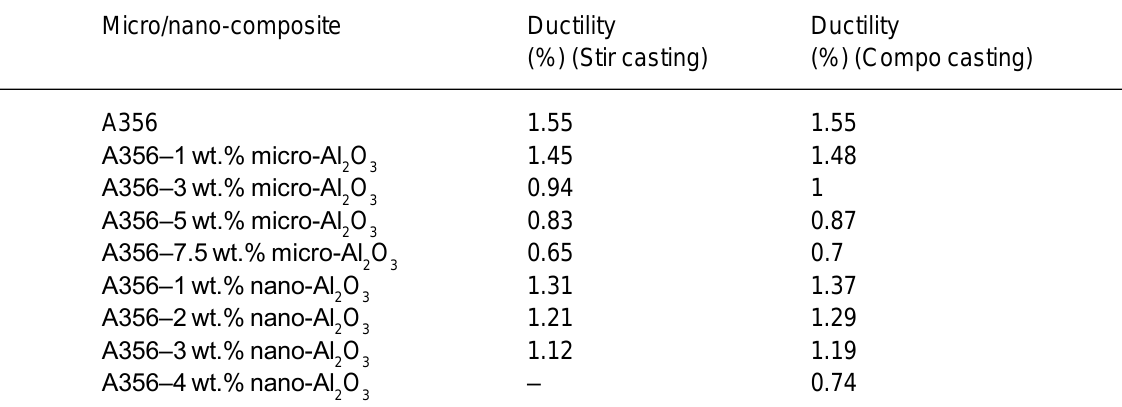
Table 3. The ductility of the micro and nano-composite fabricated by compo and stir casting process data from